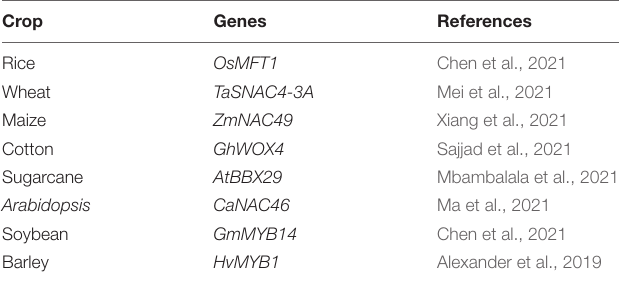
TABLE 2 | Different TFs for drought tolerance in economically essential